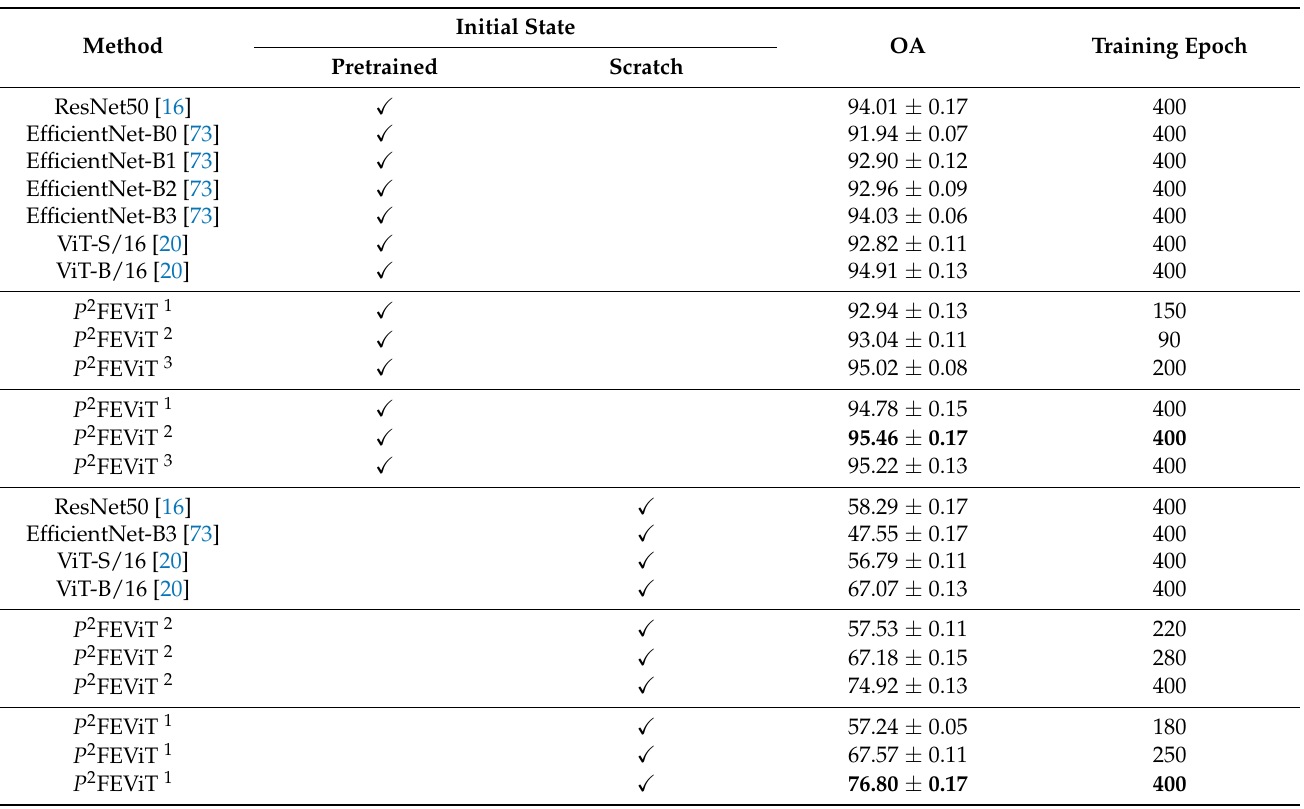
Figure 11. Samples of different categories with high inter-class similarities in NWPU-R45. Table 3. Overall accuracy (OA) and training epoch of comparison methods with the different initial state on the BIT-AFGR50 dataset